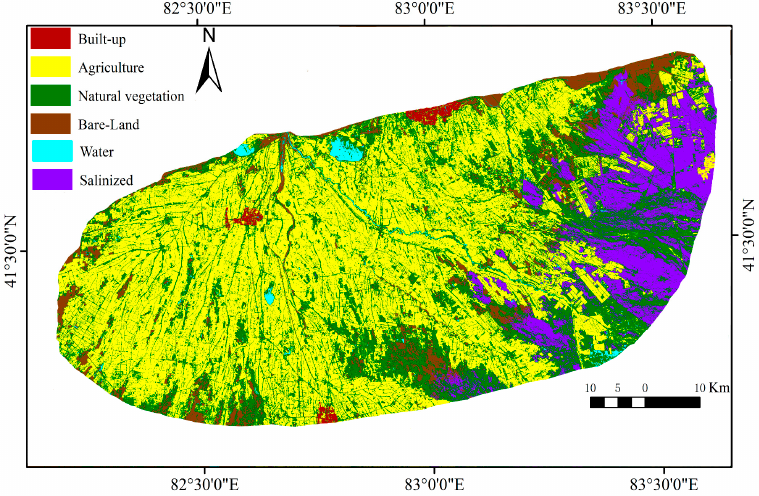
Figure 2. Land cover of study area (data source: Landsat-8 OLI, July 14, 2017).